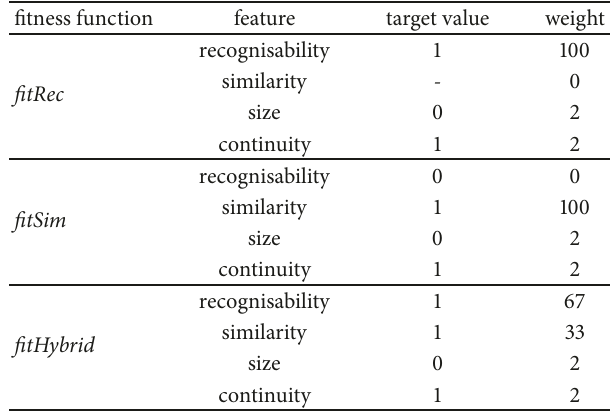
Table 4: Fitness functions designed and tested in experiment